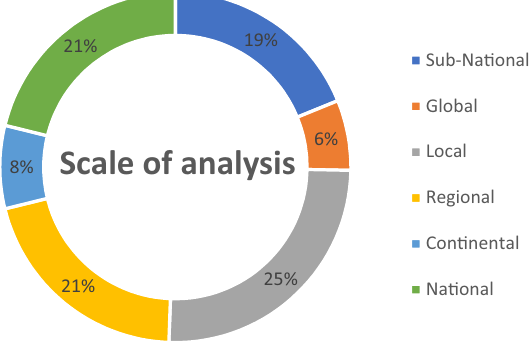
Fig. 4 Studies by scale of